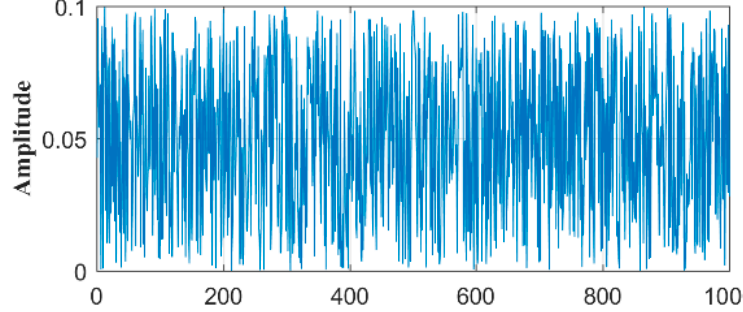
Figure 2. White noise waveform.